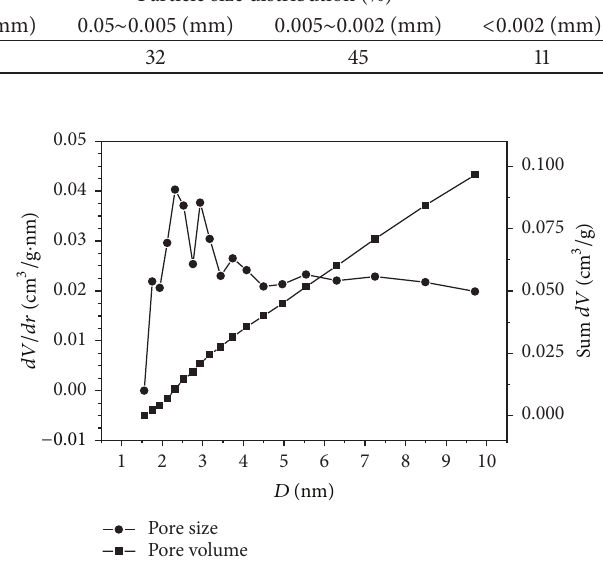
Figure 2: The pore volume and pore size distributions of